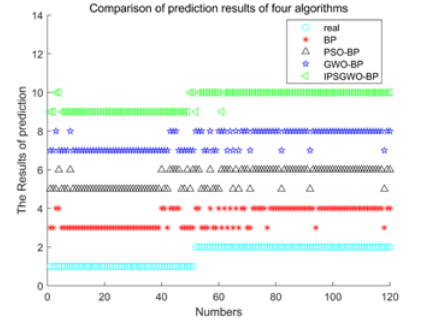
Fig. 2. Comparison between prediction results and real results of the four algorithms.